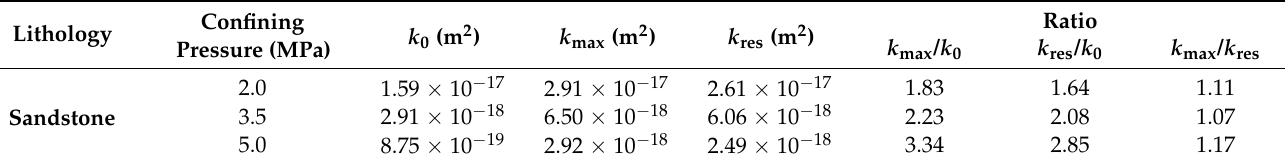
Table 2. WCS permeability thresholds (initial, maximum, and residual) in the complete stress– strain